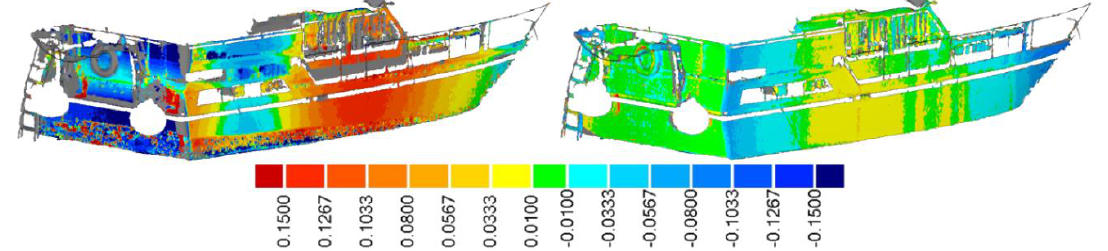
Figure 11: Colour coded inspection map [m] of the reference datasets vs. kinematically captured data (left) and corrected data